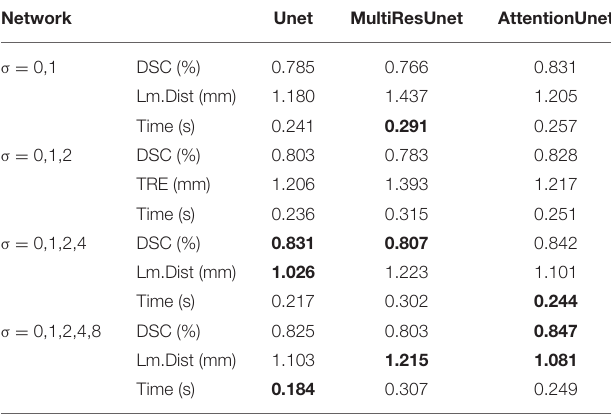
TABLE 4 | Registration performance of carotid artery using different variance set. Network Unet MultiResUnet